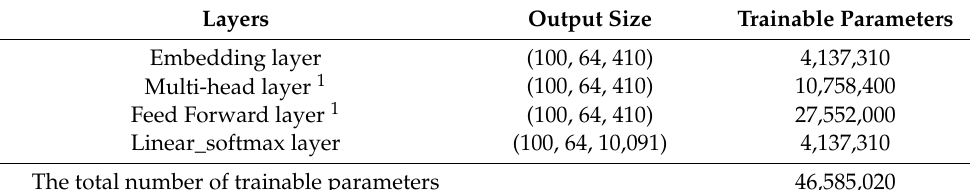
Table 1. The model structure and parameters. Layers Output